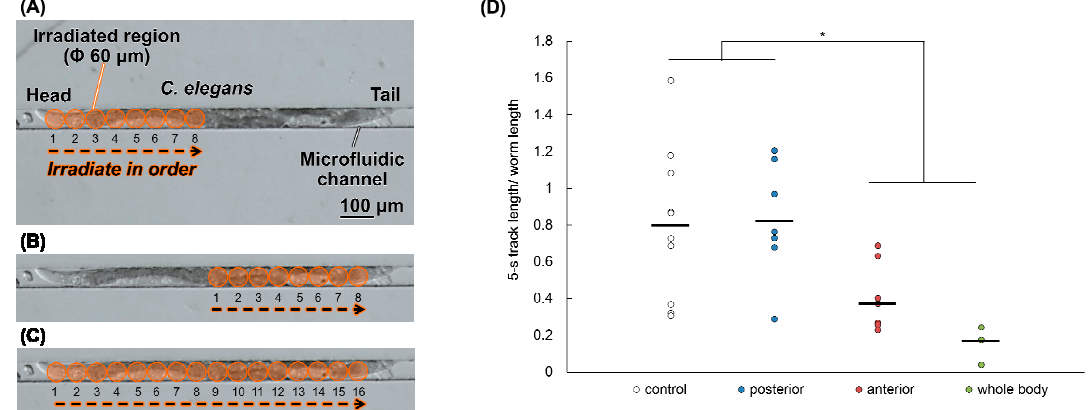
Figure 8. Crawling ability of C. elegans immediately after carbon-ion microbeam irradiation. Well-fed adult worms were enclosed in a PDMS microfluidic chip before microbeam irradiation with carbon ions. We used a Φ 60- µ m micro-aperture (beam exit), and whole- or half-body irradiation was performed by shifting the sample stage of the microbeam irradiation facility at every 60 μ m and irradiating each spot in order. Procedures for ( A ) anterior half-body irradiation; for ( B ) posterior half-body irradiation; and for ( C ) whole-body irradiation. After microbeam irradiation, worms were transferred to fresh NGM plates with a bacterial lawn. Crawling of each worm on agar was video-recorded. ( D ) To evaluate motility immediately after carbon-ion microbeam irradiation, the 5-s track length (trajectory) of the center point of the body in crawling on agar was derived from a video based on the procedure shown in Figure 2B and divided by the worm length. Each circle represents the value of 5-s track length per worm length of a single worm and the box represents mean of each group. The number of the tested worms of each group was as follows: n = 11 for the non-irradiated control group (black circle); n = 8 for the anterior half-body irradiated group (blue circle); n = 9 for the posterior half-body irradiated group (red circle); and n = 3 for the whole-body microbeam irradiated group (green circle). The data were analyzed by the Student’s t-test. * indicates p -value < 0.05, significantly different from non-irradiated control group (0 Gy) and/or posterior half-body irradiated group. Posterior half-body irradiated group was not significantly different from control group. Anterior half-body irradiated group and whole-body irradiated group were significantly different from not only control group but also posterior half-body irradiated